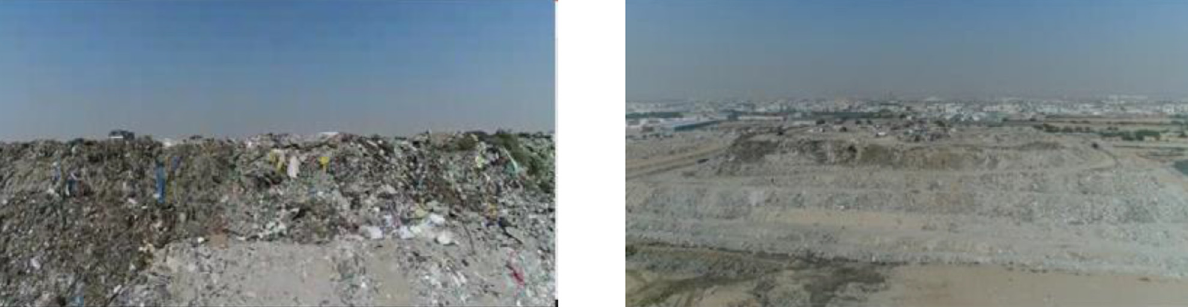
Fig. 4. Ajman Land fi ll [4].